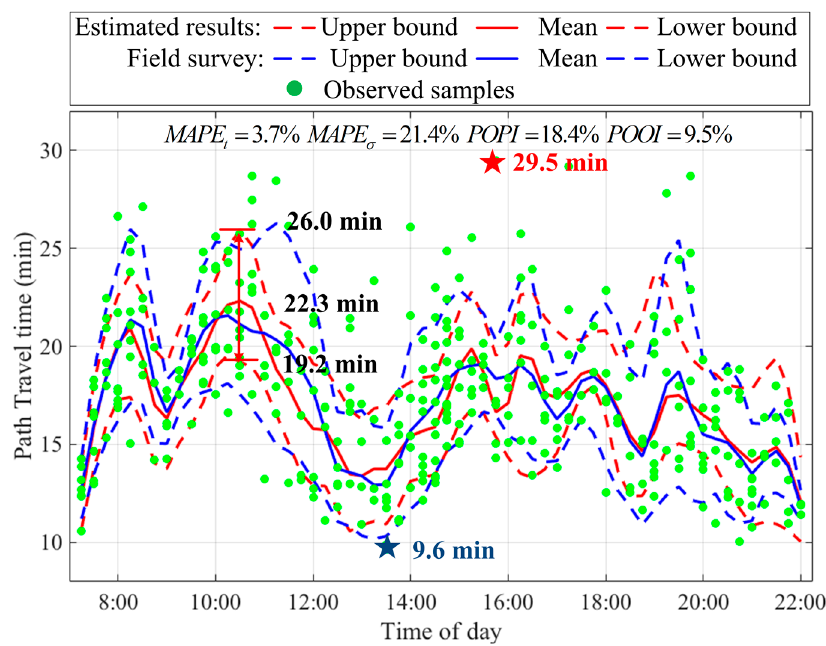
Figure 8. The estimated and observed path travel time distributions during the period of interest.